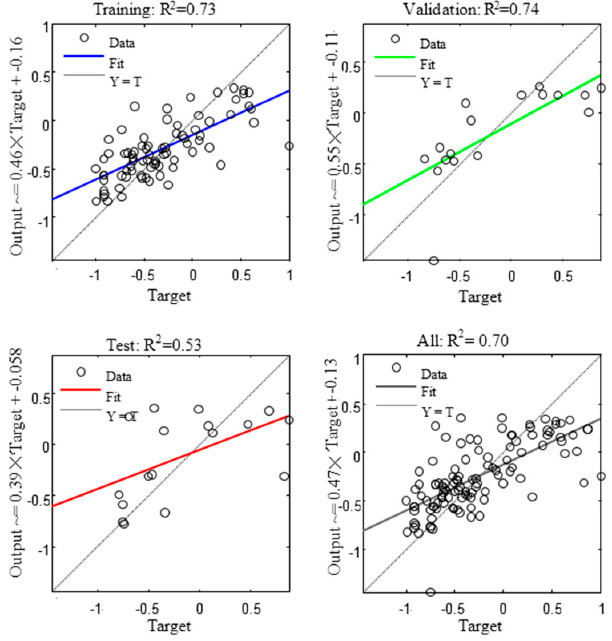
Figure 13. Fitting of the BP neural network to the NO 3 − -N effluent concentrations.